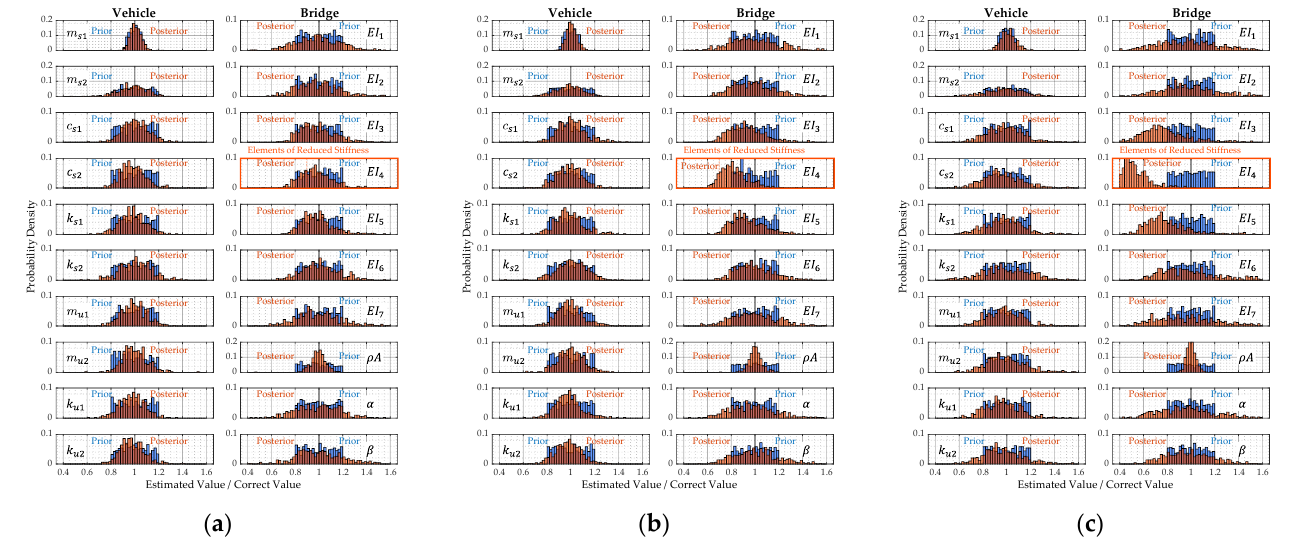
Appl. Sci. 2023 , 13 , x FOR PEER REVIEW 21 of 39